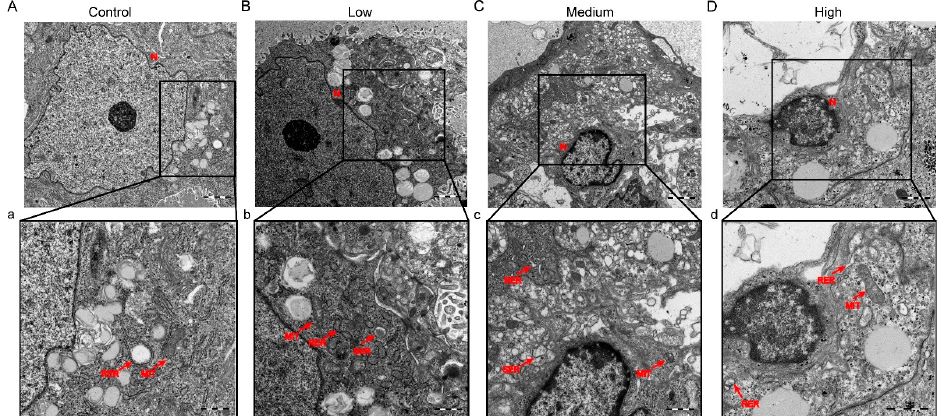
Figure 3. Effects of gestational cyfluthrin exposure on the placental ultrastructure by TEM evaluation. Pregnant rats were administered corn oil or different doses of cyfluthrin(6.25, 12.5, or 25 mg/kg) daily in pregnancy. Rat placentas were collected on GD19. ( A – D ) Transmission Electron Microscope images of the placenta in the transverse plane. Original magnification: 20,000×.Scale bars = 2 μ m. ( a – d ) Transmission Electron Microscope images of the placenta in the transverse plane. Red arrows indicate nucleus, smooth endoplasmic reticulum, rough endoplasmic reticulum, and mitochondrion. Original magnification: 30,000×. Scale bars = 1 μ m.